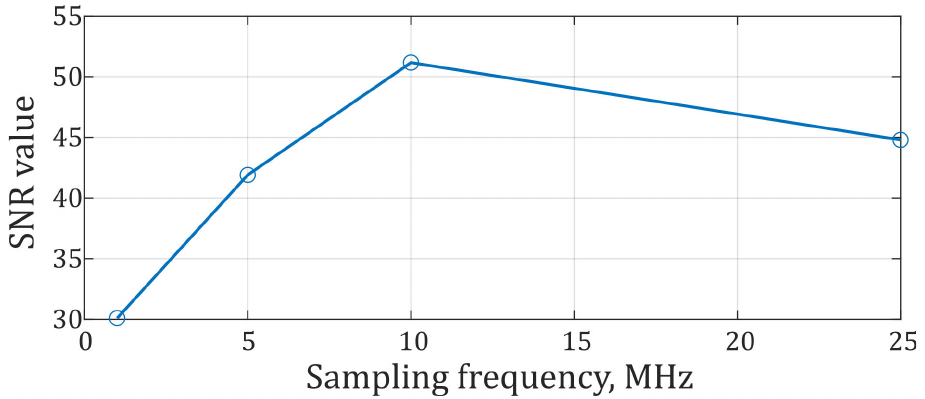
Figure 15. The SNR averaged over 100 realizations for different sampling frequencies. For each sampling frequency, 100 data realizations were processed according to the specified algorithm with interpolation. For every sampling frequency value, coordinate distribution histograms were plotted. An example of a histogram for the 25 MHz sampling frequency with its Gaussian approximation is shown in Figure